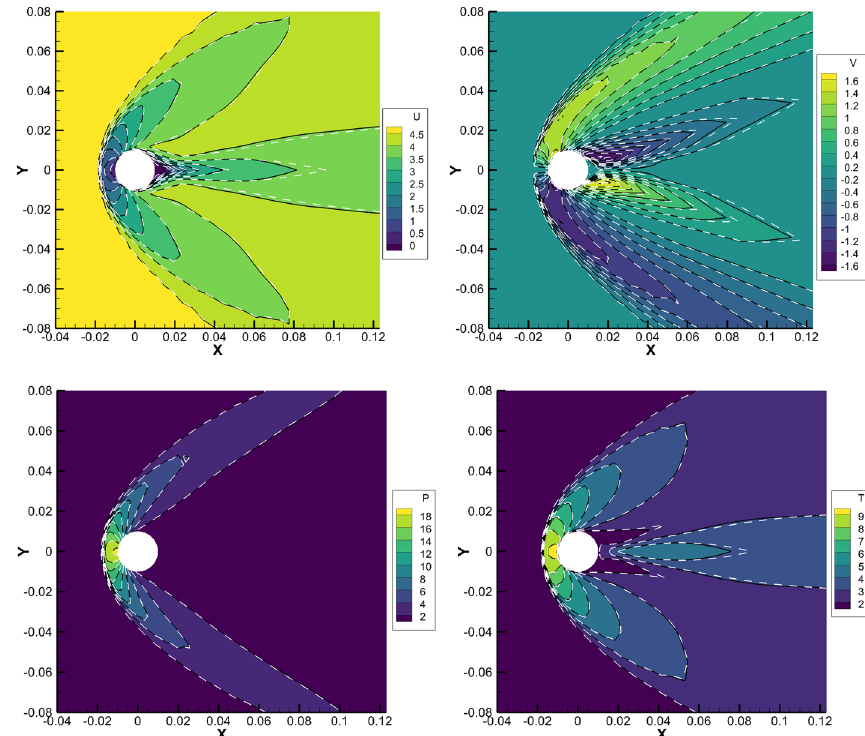
Fig. 16 Comparison of u -velocity, v -velocity, pressure and temperature contours for flow around a circular cylinder at Ma 5 and Kn 0.001 (ADUGKS: colored background with black solid line; DUGKS: white dashed = =